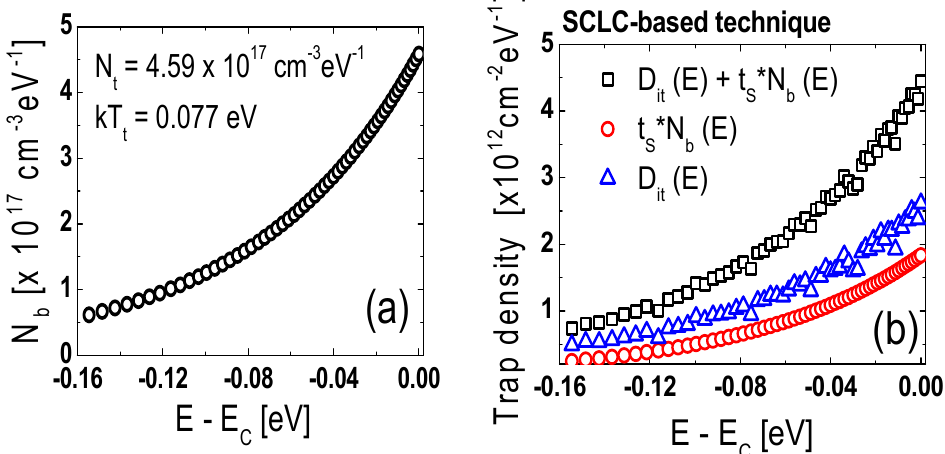
Figure 8. ( a ) Energy distribution of the density of bulk trap states N b calculated with the SCLC-based technique. ( b ) Energy distributions of the total subgap DOS D it + t S × N b , the density of interface trap states D it , and the density of bulk trap components t S × N b obtained using the SCLC-based technique.